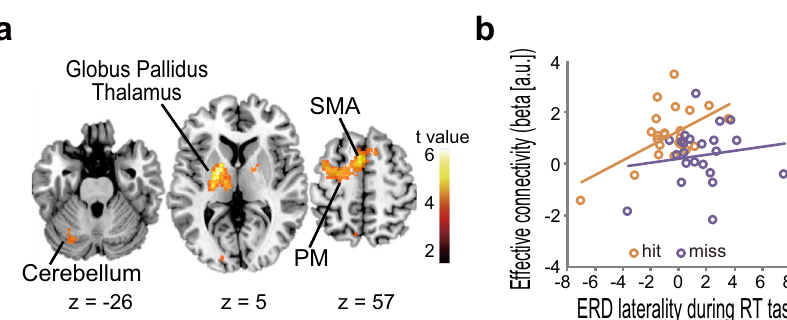
Fig. 4 Motor cortex-basal ganglia connectivity correlates with successful BCI control. a Hit-related effective connectivity with the left motor striatum increased in the cerebellum, globus pallidus, thalamus, and cortical motor areas, including the supplementary motor area (SMA) and dorsal premotor cortex (PM). b Effective connectivity between the motor striatum and SMA correlated with the laterality of event-related desynchronization (ERD) during the hit trials ( r = 0.56, permutation test P = 0.012) but not during the miss trials ( r = 0.15, P = 0.497) of the right-target (RT) task. Each circle represents data from one individual.